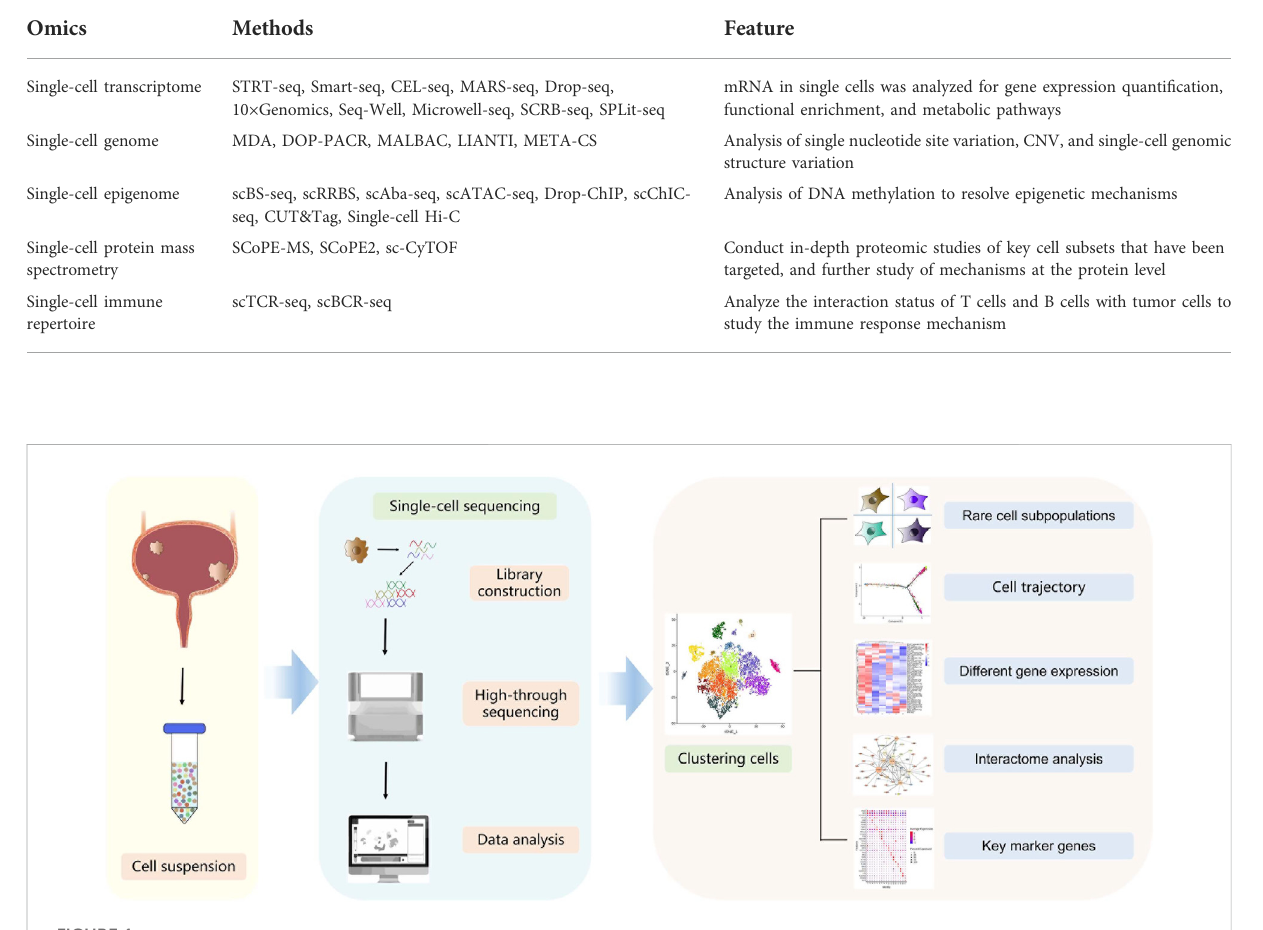
FIGURE 1 Schematicdiagramofthesingle-cellsequencingwork fl ow.Cellsaredissolvedfrombladdertumorsintosingle-cellsuspension. Singlecellsare then processed into the reaction system followed by reverse transcription, ampli fi cation, library construction and sequencing. Sequencing data are processed via bioinformatic analysis such as cell clustering, cell trajectory, different gene expression, interactome or key marker genes